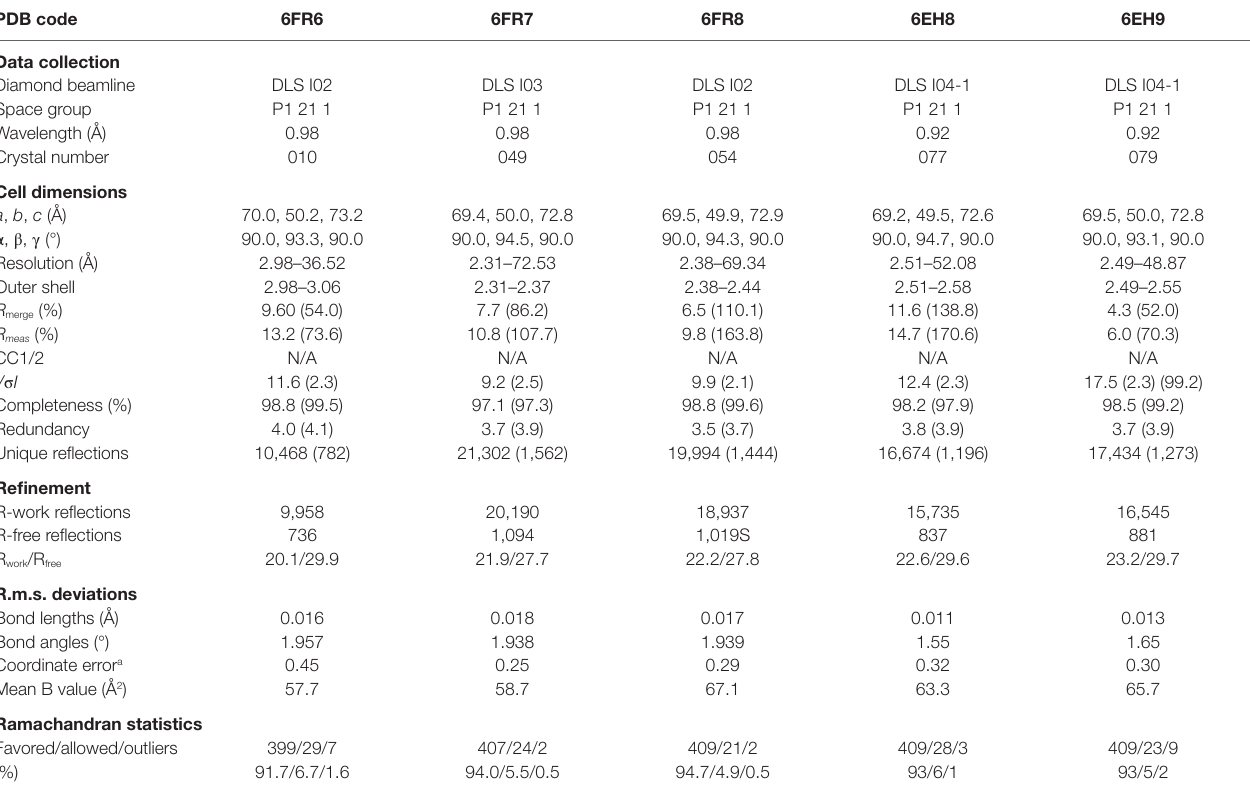
Table 3 | Data collection and refinement statistics for HA1.7 T cell receptor